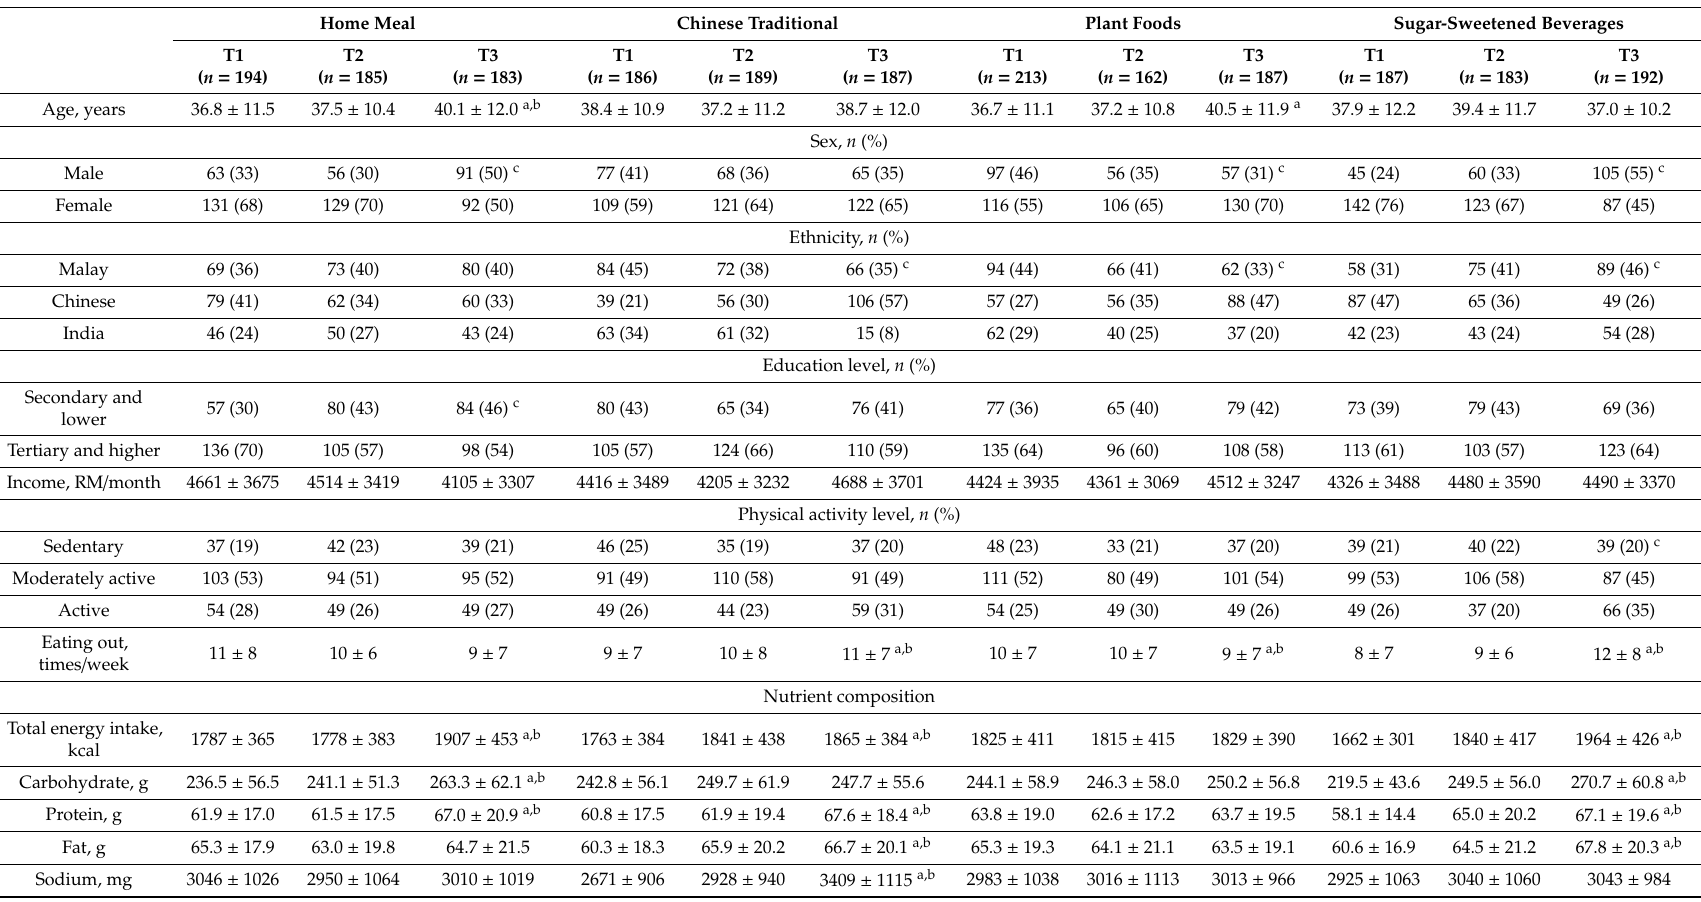
Table 3. Population characteristics as per dietary